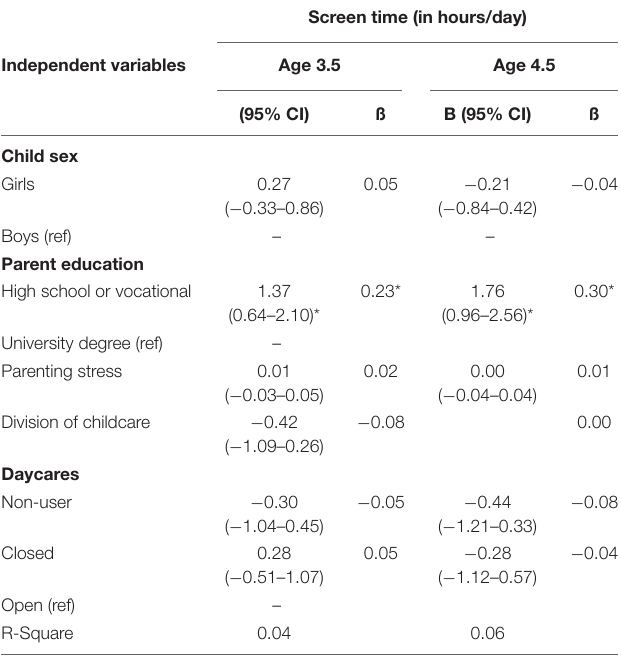
TABLE 3 | Associations between family characteristics and child screen time at Ages 3.5 and 4.5. Screen time (in